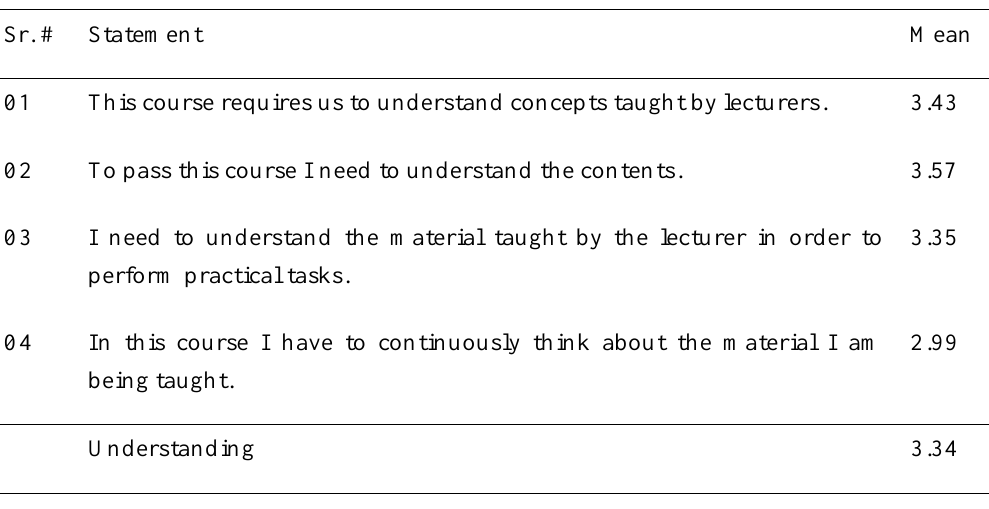
Students’ Thinking Practices to Gain